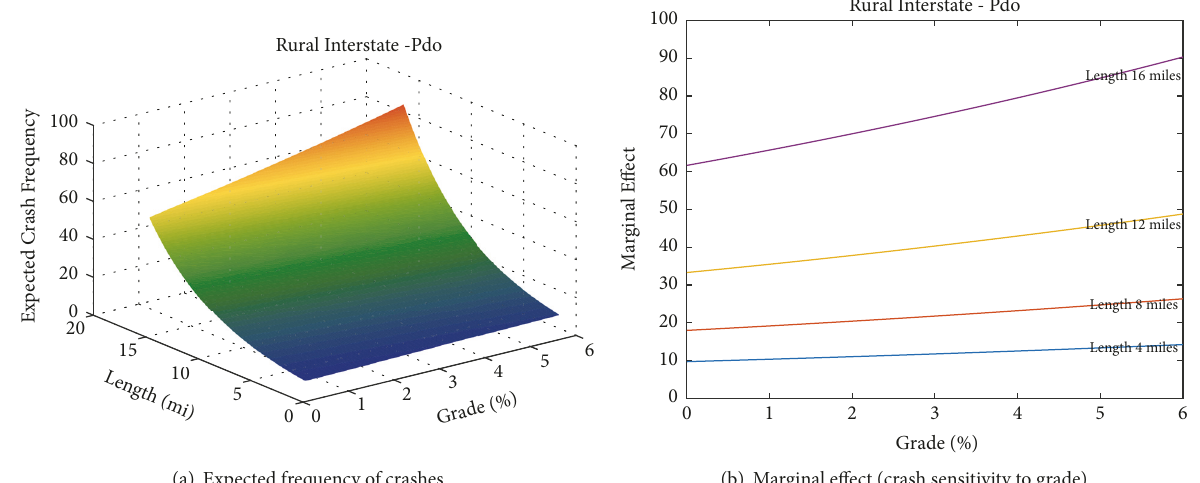
Figure 3: Rural interstate PDO crashes.